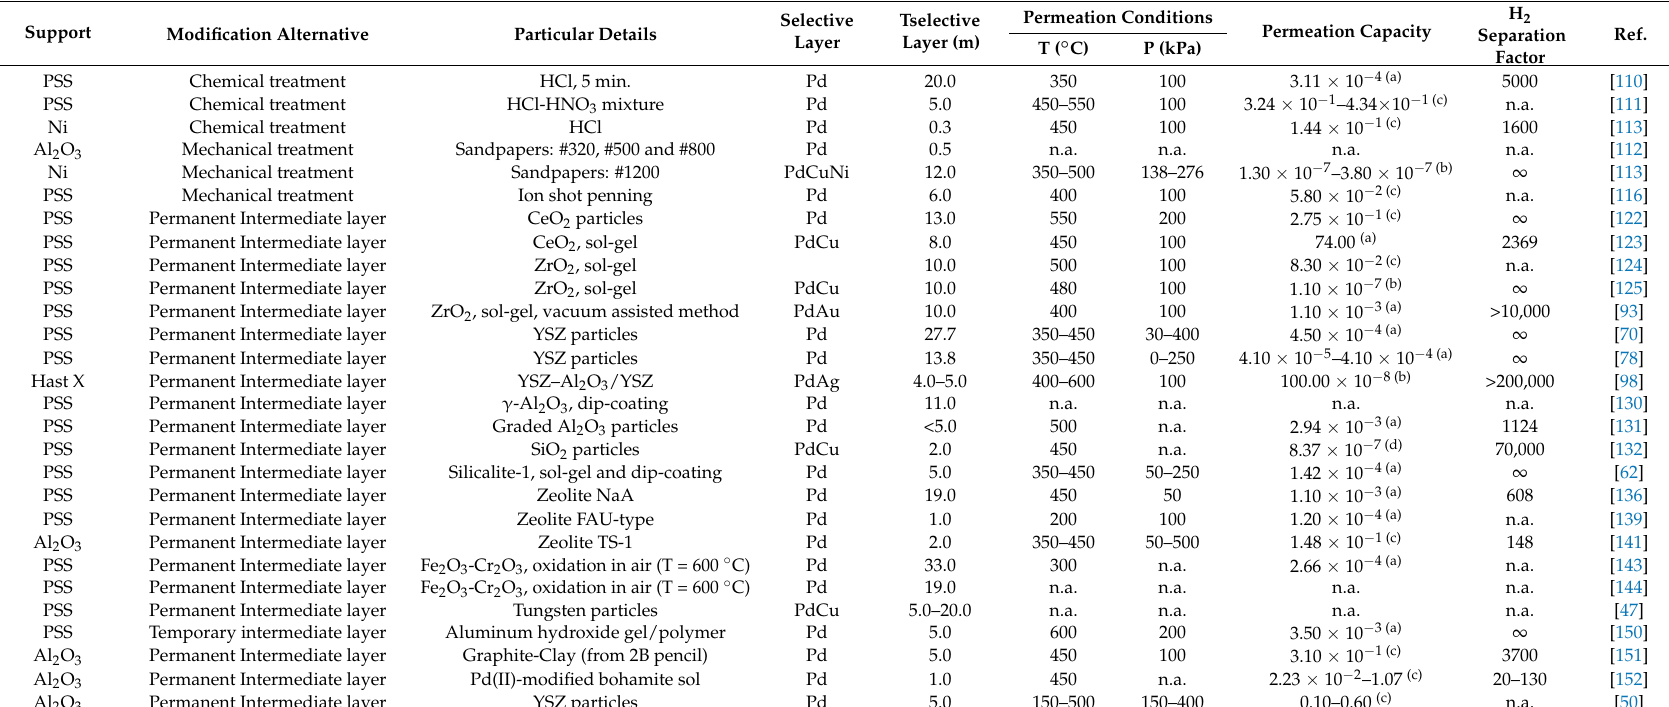
Table 2. Inorganic commercial supports for supported Pd-based membrane